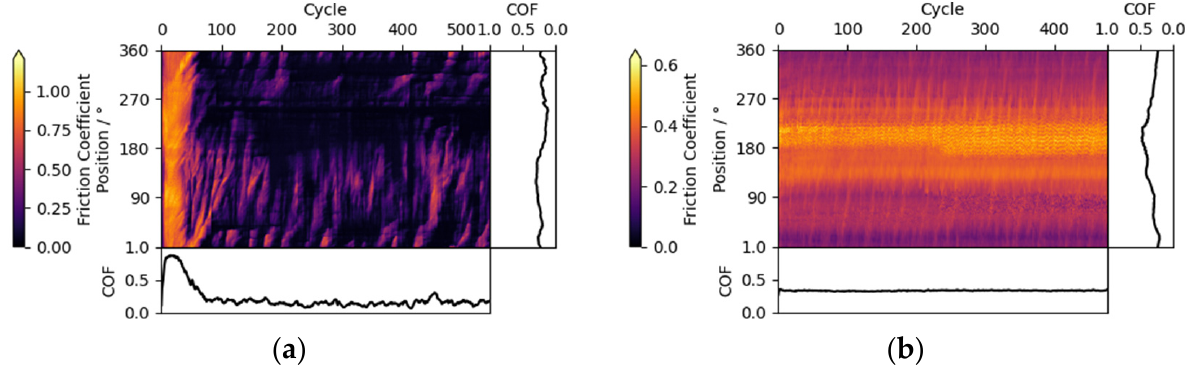
Figure 7. ( a ) Friction triboscopic image demonstrating SPORADIC features from wear debris for a